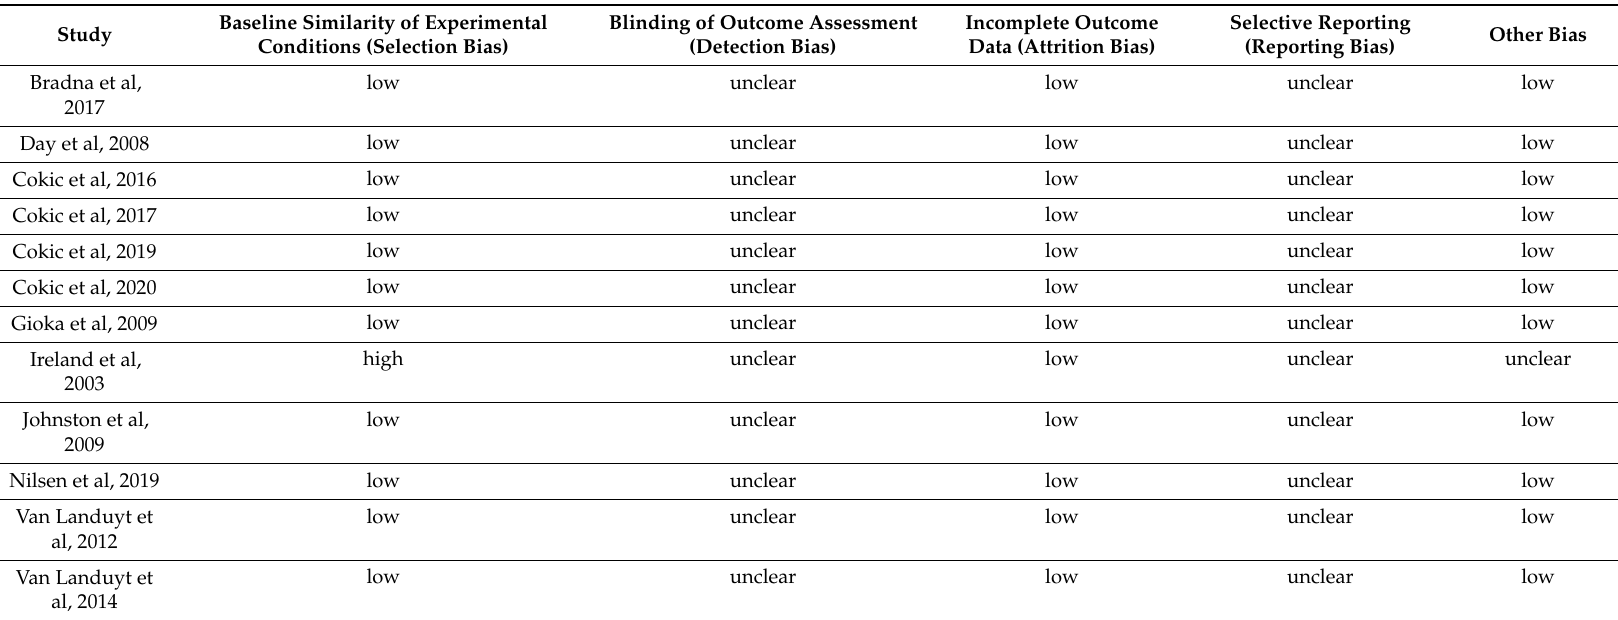
Table 2. Risk of bias assessment of included studies (in vitro and in vivo) ( n = 12).